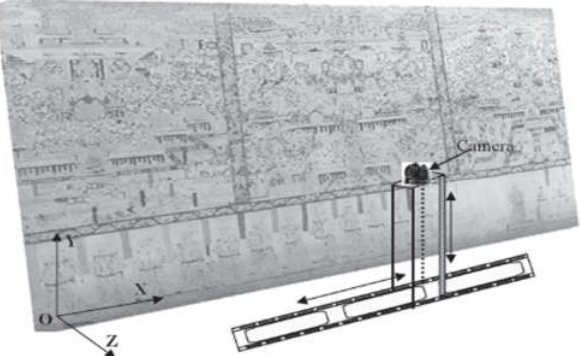
Figure 1. Photographic Structure of Dunhuang Wall Paintings (Zhang et al.